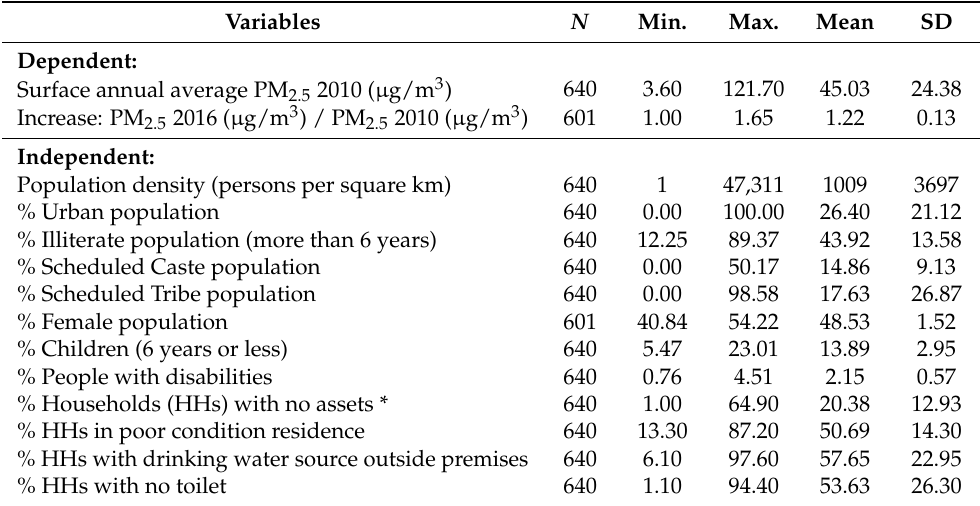
Table 1. Summary statistics for variables analyzed (unit of analysis: district).